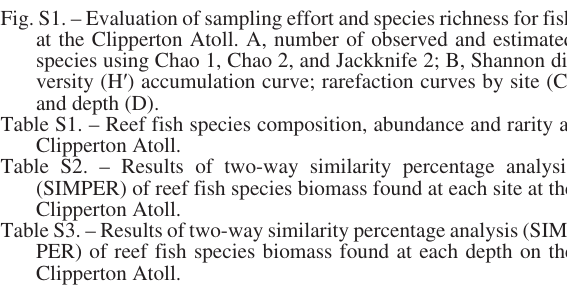
Fig. S1. – Evaluation of sampling effort and species richness for fish at the Clipperton Atoll. A, number of observed and estimated